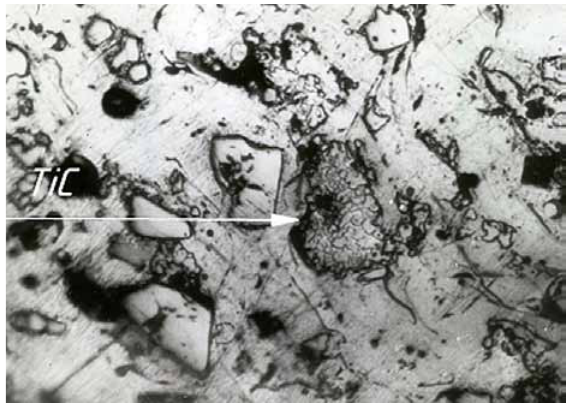
Fig. 1. Structure of the TiC-Co system plasma coating